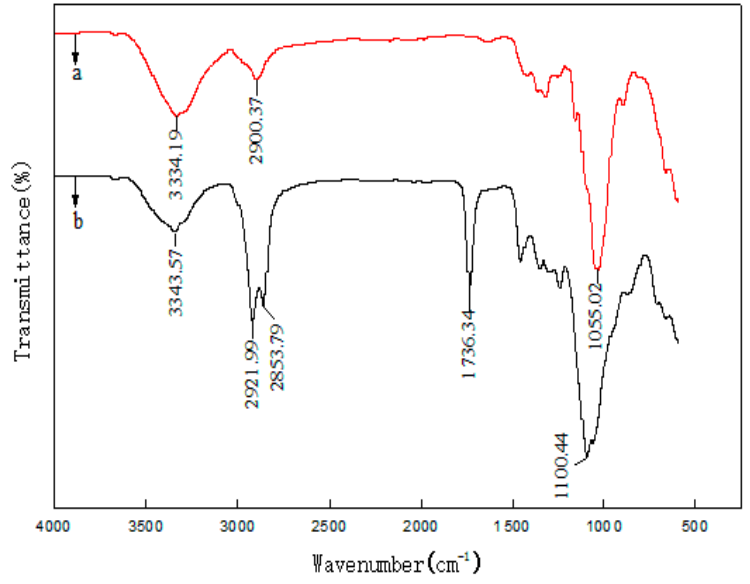
Figure 3. FTIR spectra of untreated ( a ) MFC and ( b ) surfactant-treated MFC.